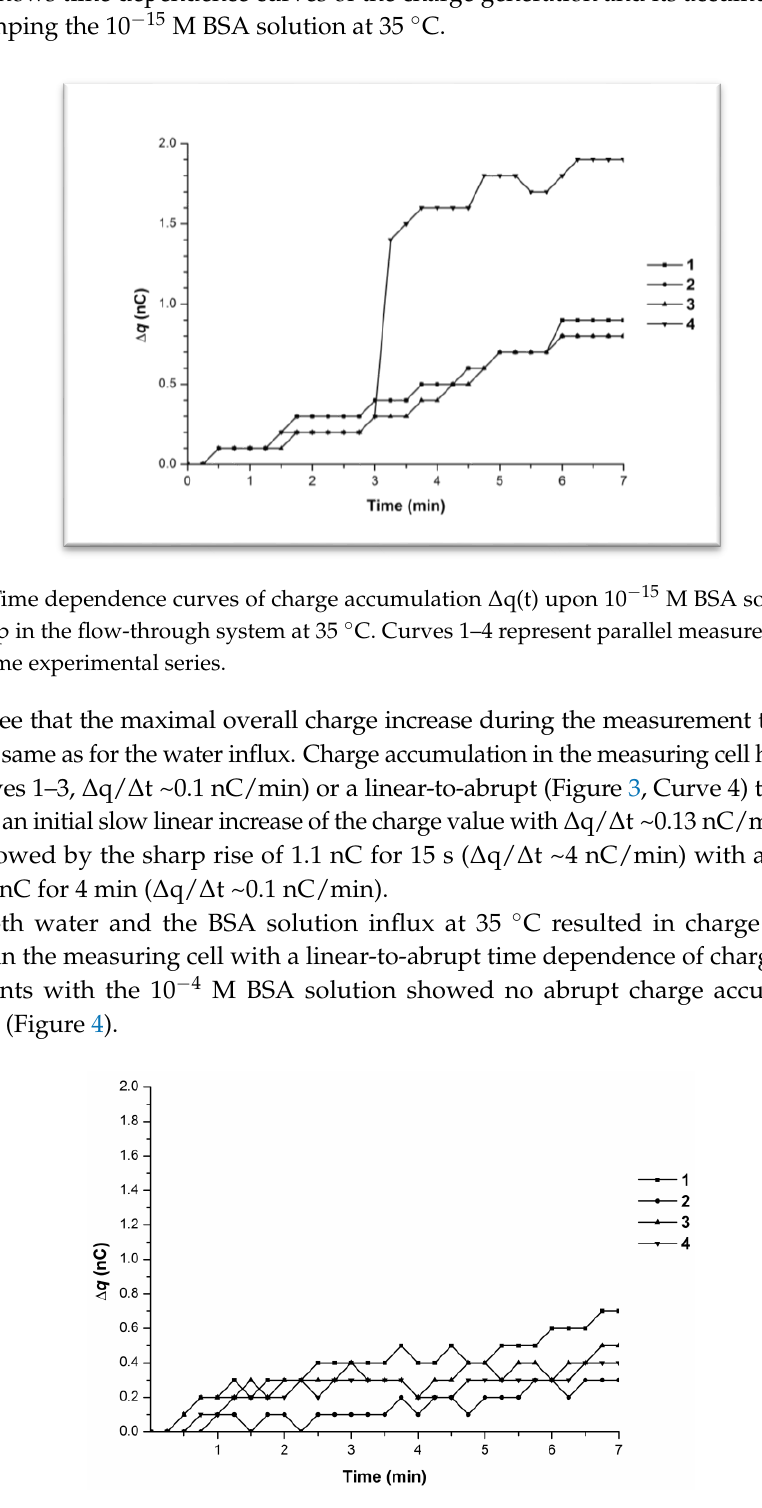
Figure 4. Time dependence curves of charge accumulation ∆q(t) upon 10 −4 M BSA solution influx from the tip in the flow-through system at 35 °C. Curves 1–4 represent parallel measurements of one and the same experimental series.